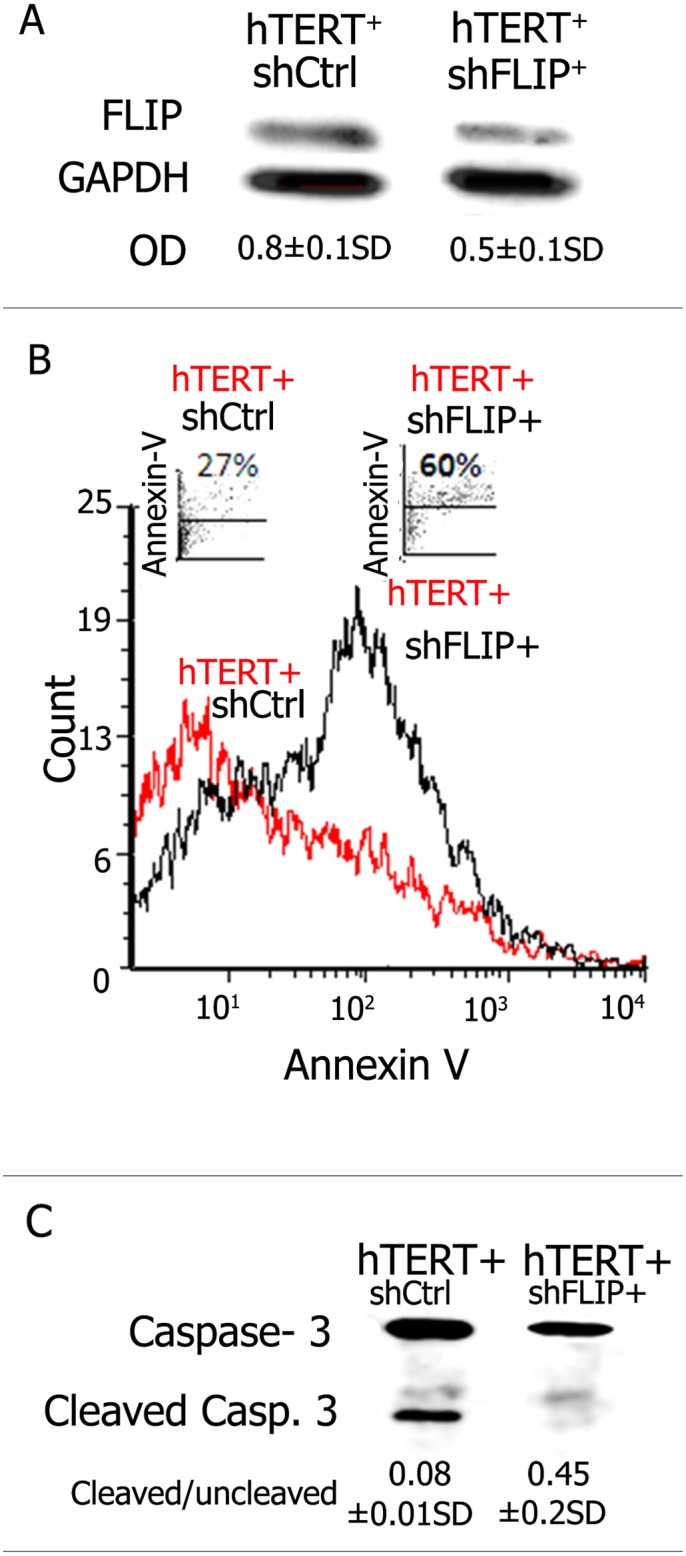
Downregulation of FLIP levels annuls hTERT-mediated resistance to Fas-induced apoptosis in human lung epithelial A549 cells.(A) Western blot of FLIP expression using anti-FLIP mAb in an hTERT+shRNACtrl (sh-scrambled/control) vs. an hTERT+shFLIP-RNA transfected-A549 cell line. OD ratios show decreased FLIP expression in hTERT+ A549 cells following further transfection with shFLIP when compared to those that were further transfected with control shRNA. (B) Histogram plot of Annexin V staining and (B) Western blot of caspase 3 cleavage in hTERT+ human lung epithelial A549 cells after infection with (hTERTshCtrl) and hFLIP-RNA lentiviral vector (hTERTshFLIP) and subjection to agonist Fas DX2 mAb. Representative results of two different experiments for each assay, with similar results showing increased apoptosis in hTERT+ A549 cells transfected with shFLIP-RNA.